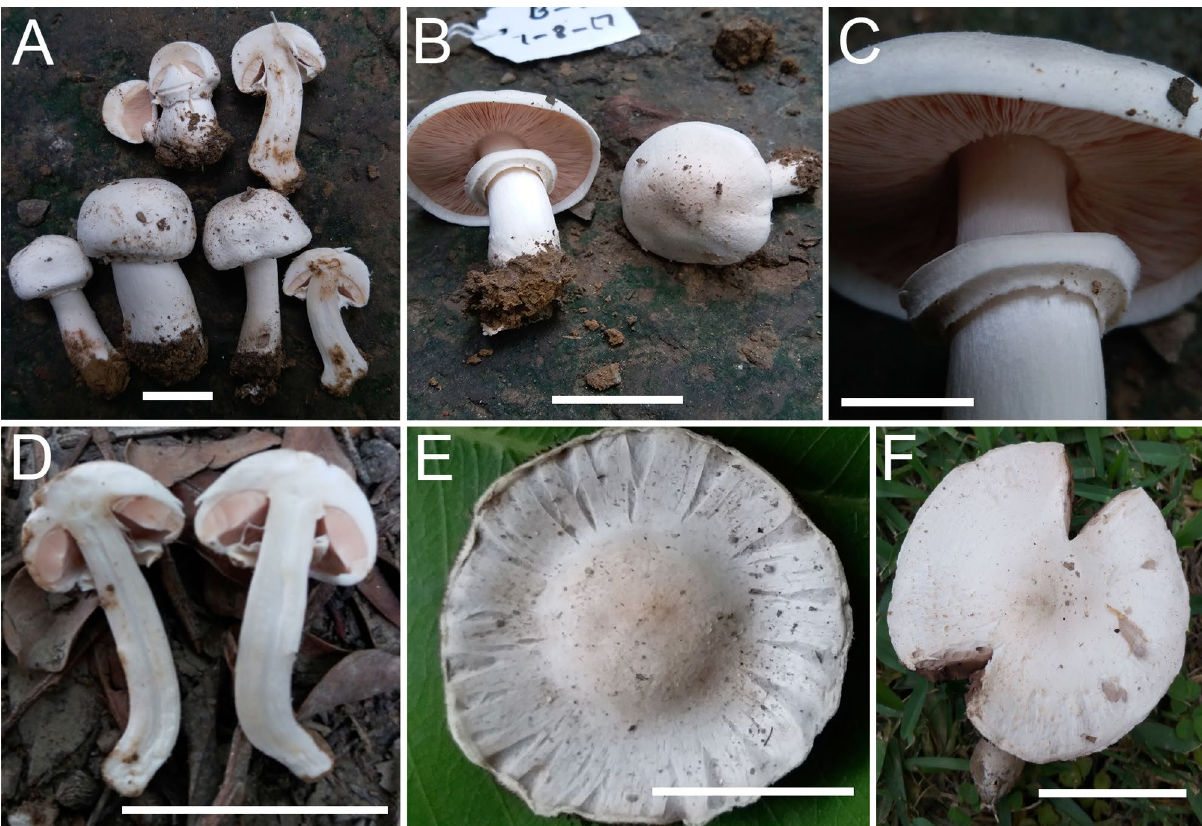
Figure 14. Macromorphological characters of A. parviniveus. (A–F) basidiomata in the field. (A–D) B40 ( Holotype ); (E) PU318; (F) PU248. Bars : (A–F) = 2 cm. Photographed by Dr. Hira rounded ends. Pileipellis constituted by cylindrical hyphae 4.0–16 µm in diam., frequently septate, branched, the wider the most constricted at the septa, with internal brown vacuolar pigmentation terminal elements with rounded tips. Stipitipellis hyphae 3–10 µm in diam., mostly cylindrical or broader more constricted at the septa with parallel arrangement, hyaline in KOH. Macrochemical reactions: KOH reaction positive, yellow. Schaeffer’s reaction negative. Habit, habitat and distribution: Growing solitary and in the group of two on grassy grounds near deciduous trees. The known distribution of this species is from deciduous forest of Swat, Pakistan until now. Additional specimen examined: Pakistan, Khyber Pakhtunkhwa, Swat District, Manglor, at 987 m a.s.l., in grass near deciduous trees, 7 Sep 2015, Junaid Khan, MW1544 (LAH35357). GenBank: ITS = MK141003. Notes: Agaricus macropeplus is morphologically very similar to many species of clade Xan III and therefore an unequivocal morphological differentiation with all taxa is not possible. Phylogenetically, Agaricus macropeplus clusters in the same clade as A. griseovariegatus , A. sinoplacomyces and A. xanthochromaticus (Figs. 1 and 2) from which it differs in the ITS sequence at 3, 5 and 6 nucleotide sites, respectively (Table 2). Agaricus griseovariegatus differs by having a pileus surface covered with brown squamules with olicaceous tones progressively scattered towards the margin but it is very difficult to distinguish A. macropeplus from A. sinoplacomyces and A. xan- thochromaticus . Agaricus sinoplacomyces was described with a pleasant odor (but this feature needs confirmation) and A. xanthochromaticus has an intense odor of phenol and slightly smaller spores on average (4.9 × 3.3 µm). Agaricus parviniveus H. Bashir & Khalid, sp. nov . Figs. 14A–F, 15A–G MycoBank: MB828266 Main characters: This species is characterized by its small size, smooth (rarely squamulose) white pileus, stipe turning brown when rubbed, collar-like triple edged annulus, context white, unchanging when cut, odor pleasant not phenolic, basidiospores 5.6 × 4.3 µm on average and basidia frequently bisporic.